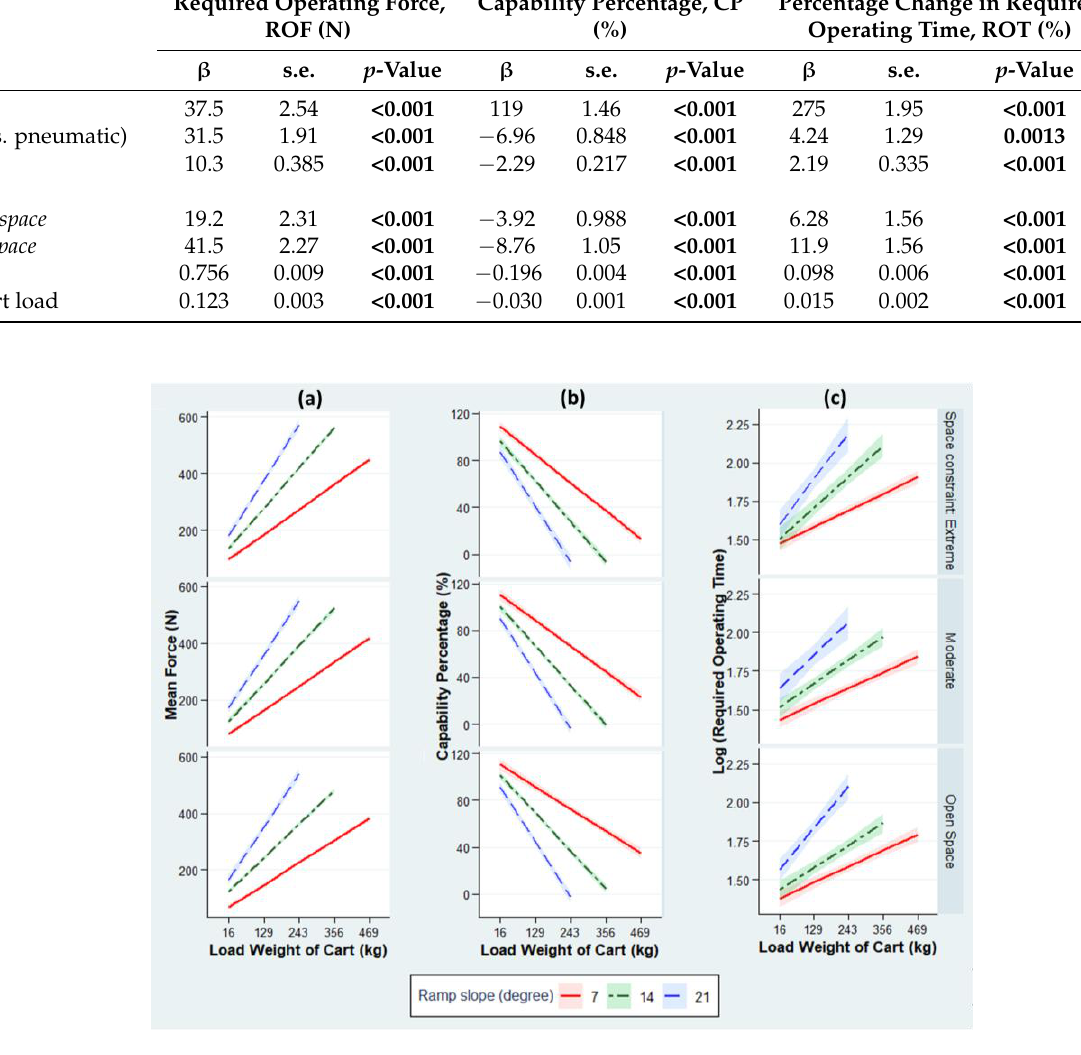
Figure 9. Estimated values: ( a ) ROF, ( b ) CP, and ( c ) ROT for three ramp slopes by fitting the actual measurements of Experiment 2b from the final linear regression models, stratified by the space constraint. Estimated values are adjusted for tire type. The ribbons indicate 95% confidence intervals.